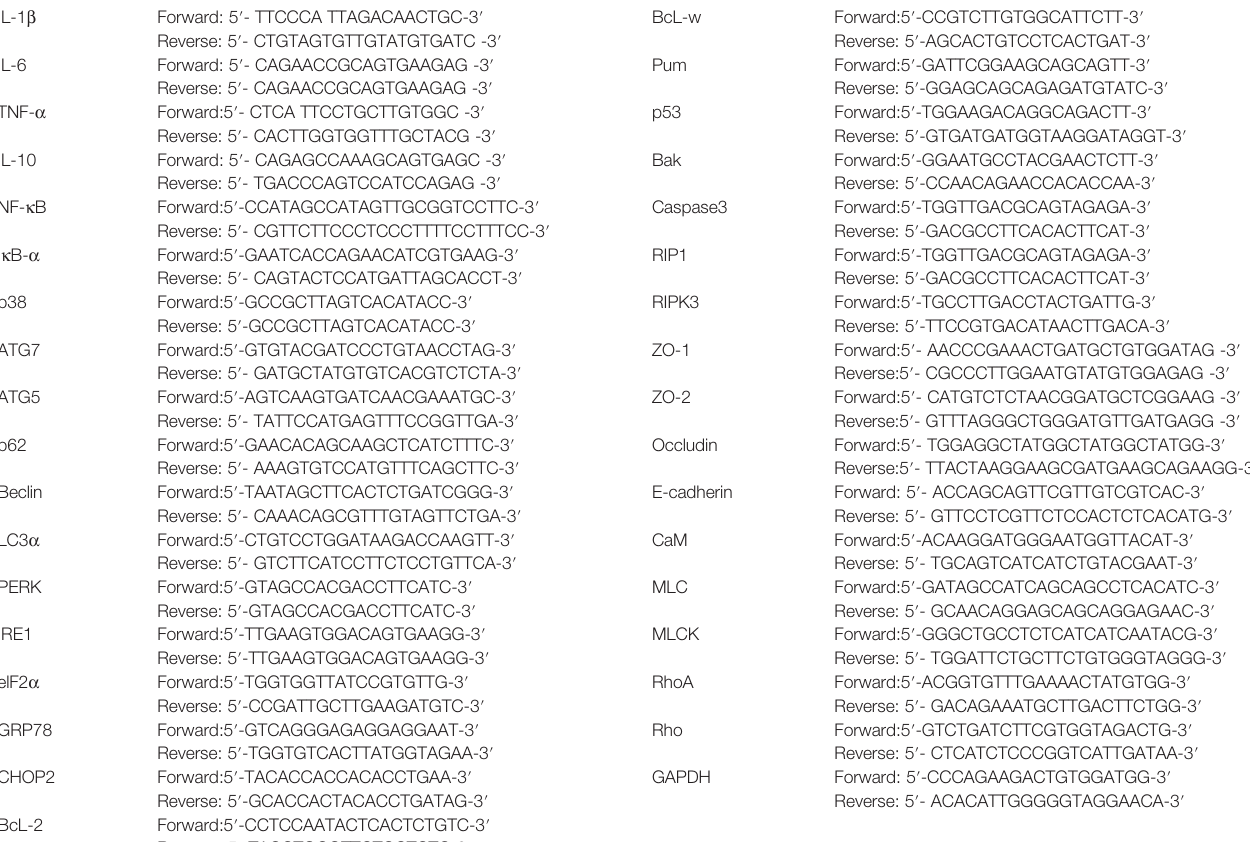
TABLE 1 | Primer sequence